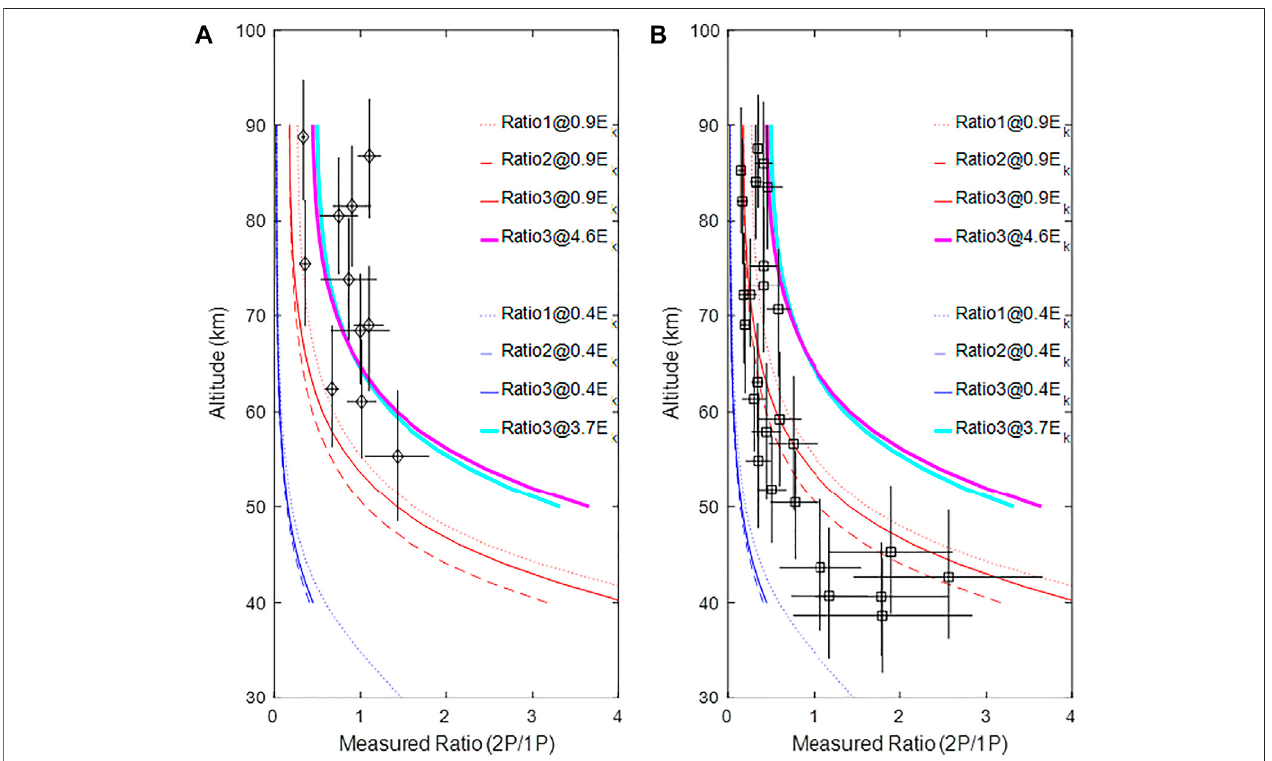
FIGURE8| AP-measuredemissionratiosof2Pto1Pfor10selectedspriteeventswithoutpotentiallightningcontamination.TwocategoriesofISUALspriteevents are shown in AP-measured ratios: (A) sprite halo events with impulse AP emission time (0.9 ± 0.3 ms) and higher estimated electric fi elds, and (B) carrot sprite events with long AP emission time (3.0 ± 0.5 ms) and lower estimated electric fi elds.